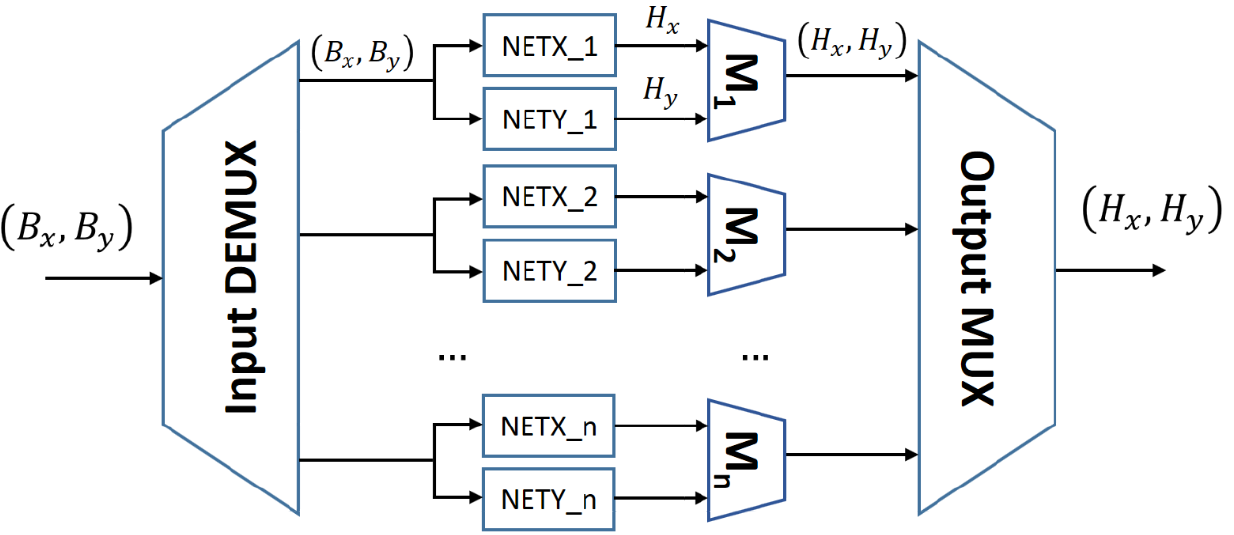
Figure 2. Block diagram of the theoretical neural system.